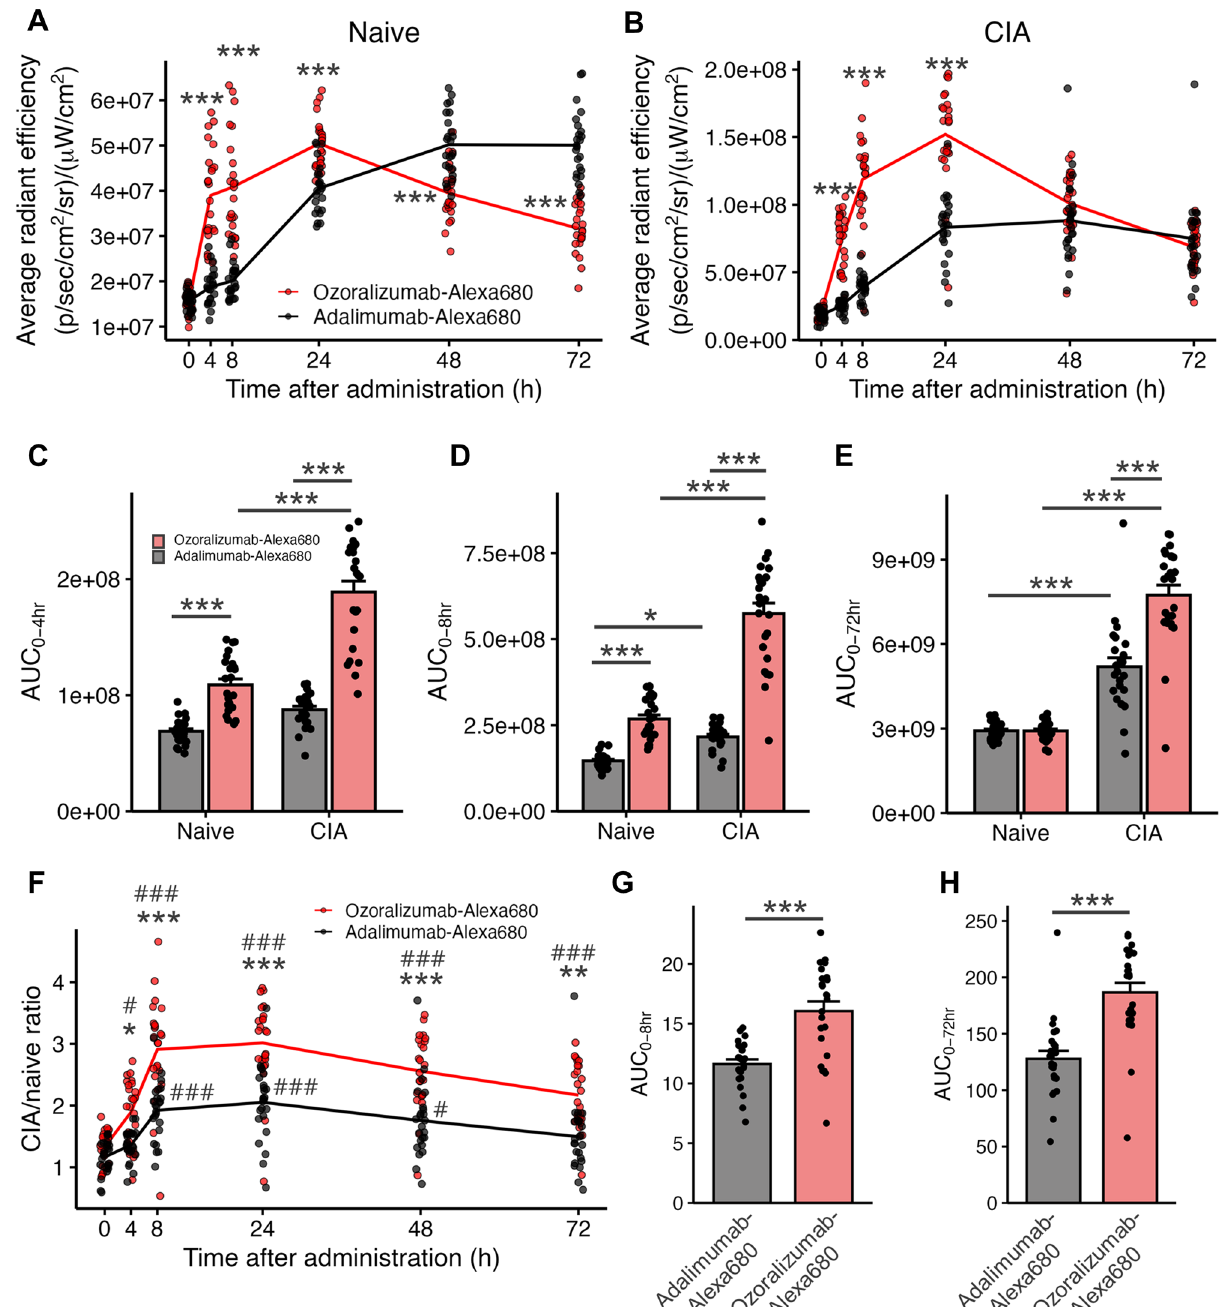
Figure 3. Time-course analysis of in vivo biofluorescence images. Quantification of the average radiant efficiency in the paws of naive mice ( A ) and CIA mice ( B ). P values were calculated by two-way ANOVA with post-hoc Tukey’s test. Area under the curve (AUC) of the average radiant efficiency from 0 to 4 h ( C ), 0 to 8 h ( D ), and 0 to 72 h ( E ). P values were calculated by two-way ANOVA with post-hoc Tukey’s test. ( F ) The ratio of the average radiant efficiency in the CIA model mice to the average radiant efficiency in naive mice over time. P values were calculated by two-way ANOVA with post-hoc Tukey’s test. AUC of the ratio of the average radiant efficiency in the CIA model mice to the average radiant efficiency in naive mice from 0 to 8 h ( G ) and 0 to 72 h ( H ). P values were calculated using Welch’s t-test. Dot plots represent each individual data, lines represent the means, and bars represent the means ± SEM. red: ozoralizumab-Alexa 680; black: adalimumab-Alexa 680. n = 24 paws (6 mice) per group. * P < 0.05, ** P < 0.01, *** P < 0.001. # P < 0.05, ### P < 0.001, vs. 0